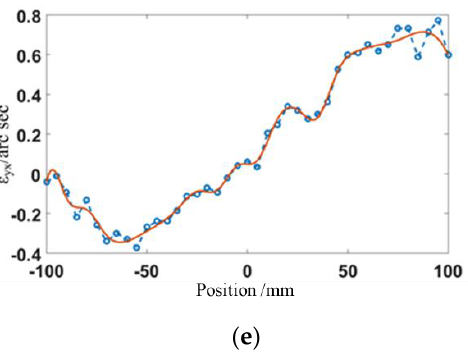
Figure 9. Geometric errors for the X − axis. ( a ) Linear displacement error δ xx ( x ) for the X − axis. ( b ) Straightness error in the Y direction δ yx ( x ) for the X − axis. ( c ) Straightness error in the Z direction δ zx ( x ) for the X − axis. ( d ) Yaw angle error ε z ( x ) for the X − axis. ( e ) Pitch angle error ε y ( x ) for the X − axis. The measured geometric errors and fitted results for the Z − axis can be seen in Figure 10.